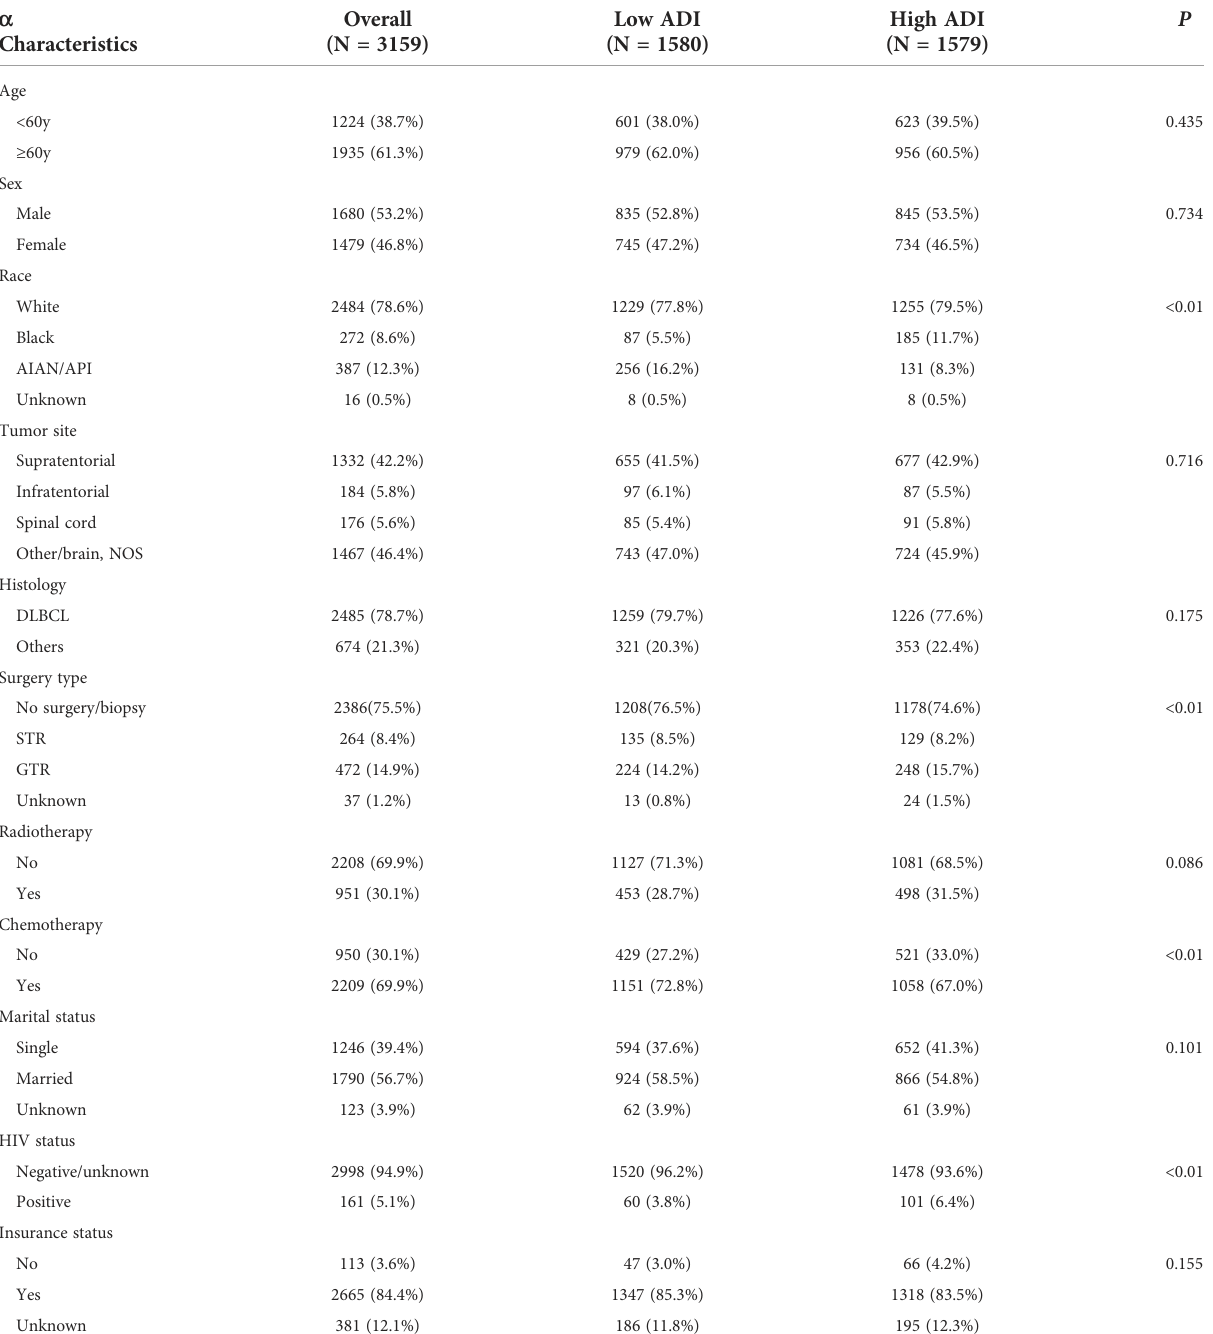
TABLE 1 Patient characteristics strati fi ed by